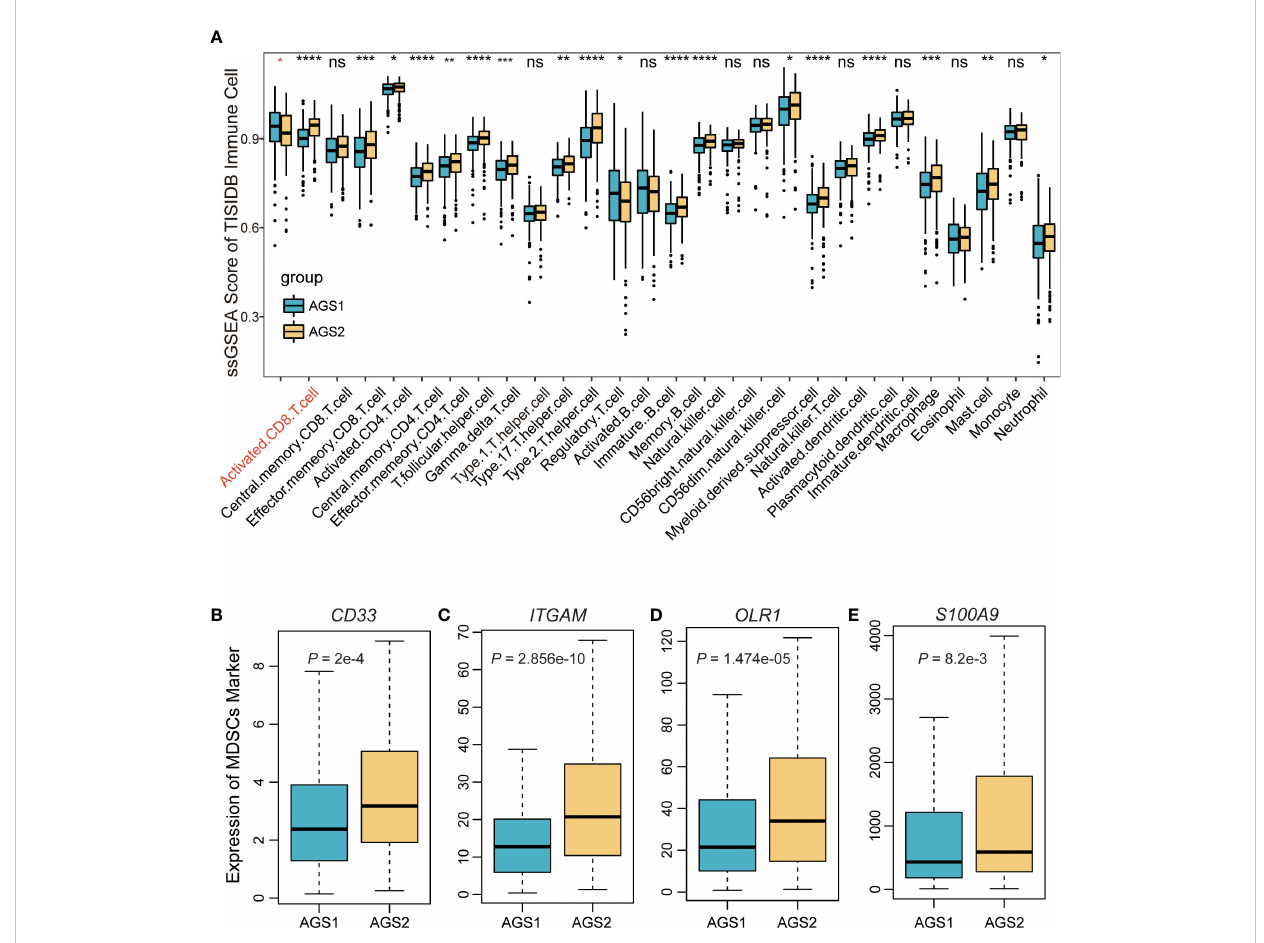
FIGURE 2 The immune landscape of AGS clusters. (A) The boxplot of the ssGSEA score of 29 immune cells based on markers from the TISIDB database. (B-E) The boxplot of MDSC markers: (B) CD33, (C) ITGAM, (D) OLR1, (E) S100A9. *, P < 0.05; **, P < 0.01; ***, P < 0.001; ****, P < 0.0001. ns represents p value is not signi fi